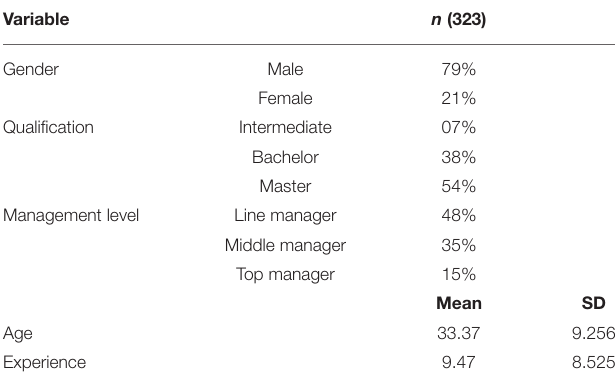
TABLE 1 | Respondents